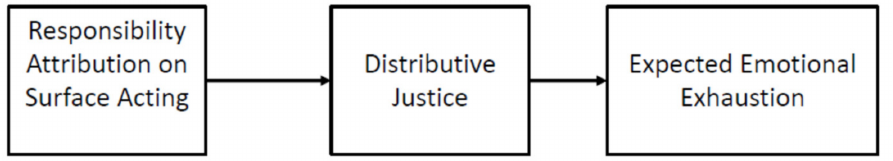
Figure 1. Responsibility attributions and distributive justice model for the surface acting and emotional exhaustion